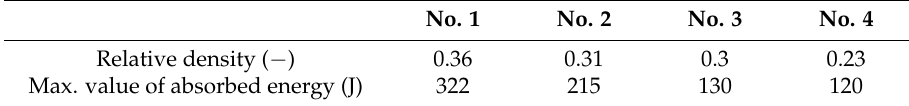
The comparison of maximum values of absorbed energy referring to honeycomb structure specimens.